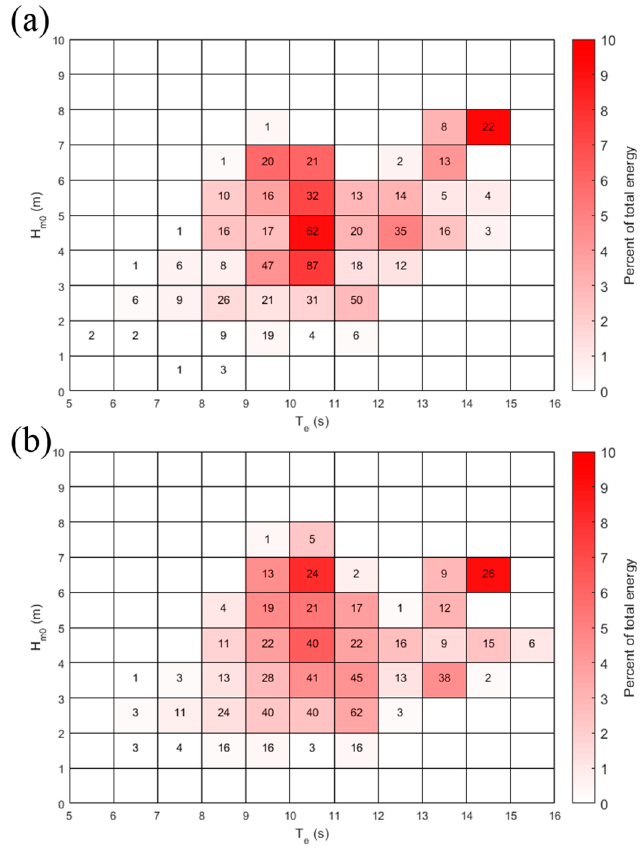
Figure 8. ( a ) UnSWAN ‐ ST2 and ( b ) UnSWAN ‐ ST4 bivariate distribution of occurrence and energy showing the probability and energy distribution defined by significant wave height and energy period.